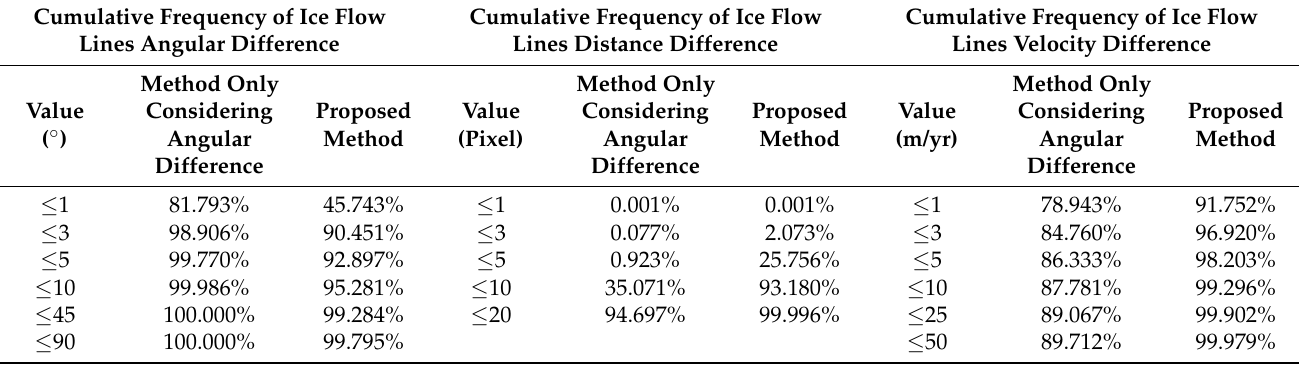
Table 2. The cumulative frequencies of angular difference, distance difference and velocity difference for the flow lines of the proposed method compared to the angular difference only